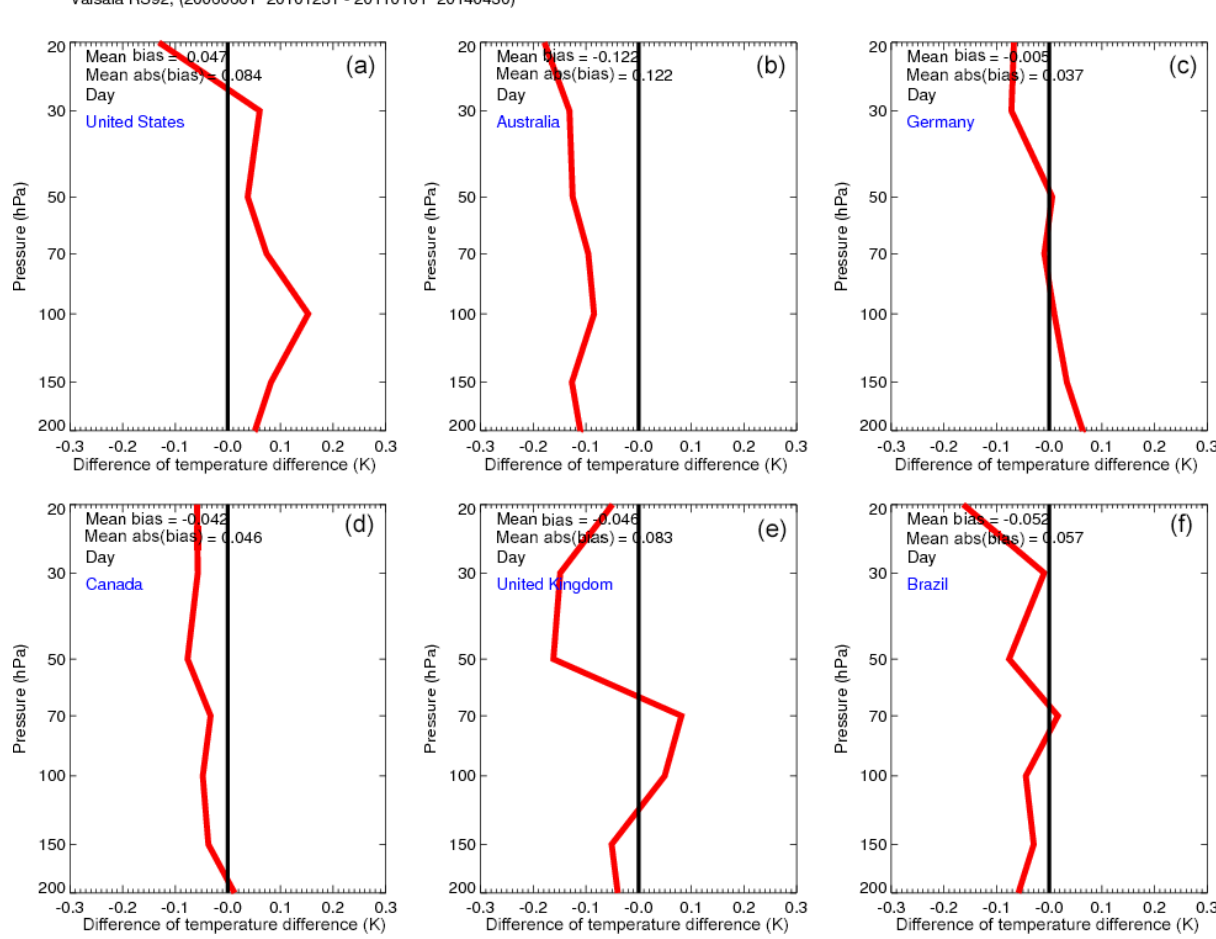
Figure 9. The temperature differences between RS92 – RO from January 2007 to December 2010 ( (cid:49)T (RS92 200701 − 201012 ) ) and those from January 2011 to April 2014 ( (cid:49)T (RS92 201101 − 201404 ) ) over (a) United States, (b) Australia, (c) Germany, (d) Canada, (e) United Kingdom, and (f)